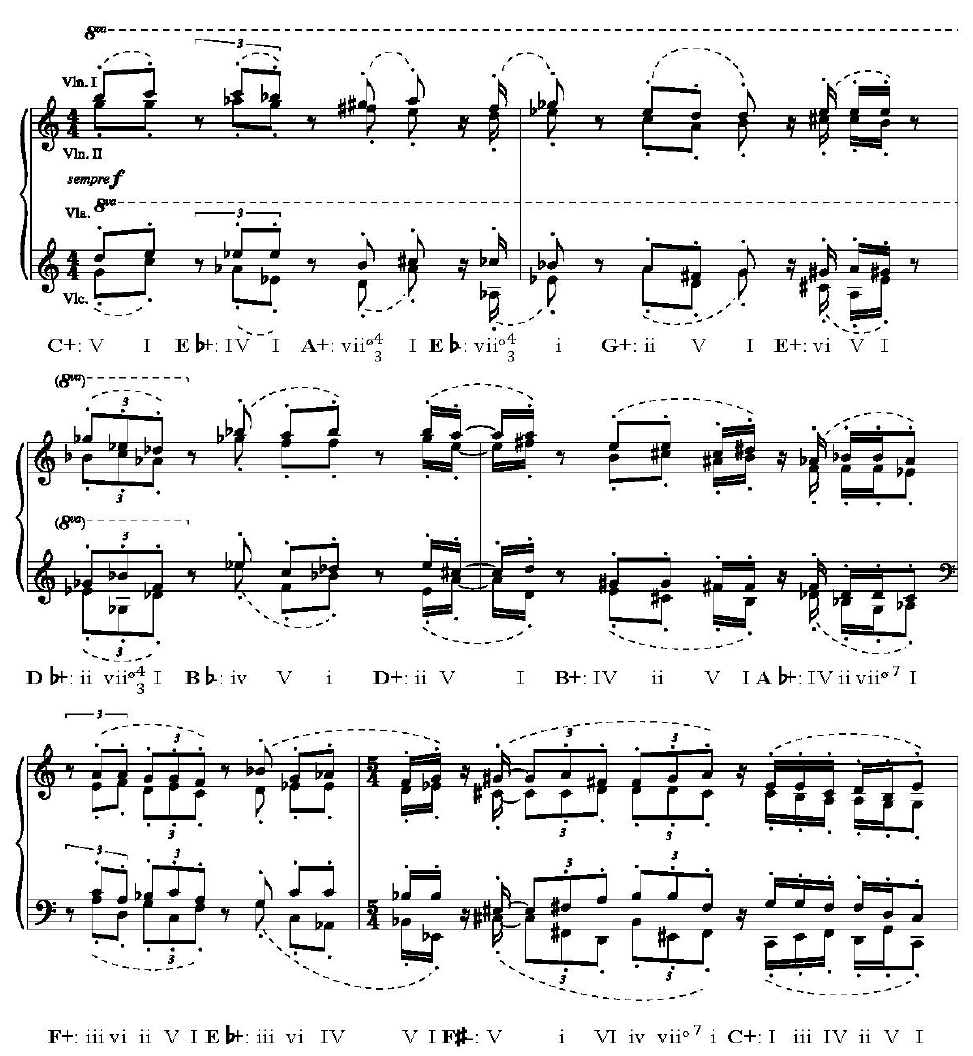
Figure 1. Macklay, Many Many Cadences , measures 1–6. Notice that each dashed slur signifies